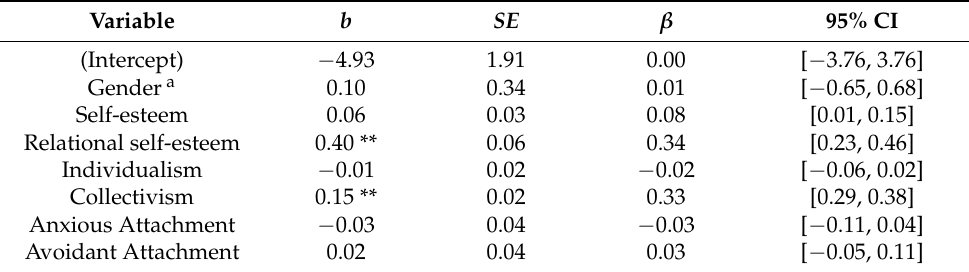
Table 4. Regression Coefficients of Study Variables on External—Family Locus-of-Hope.